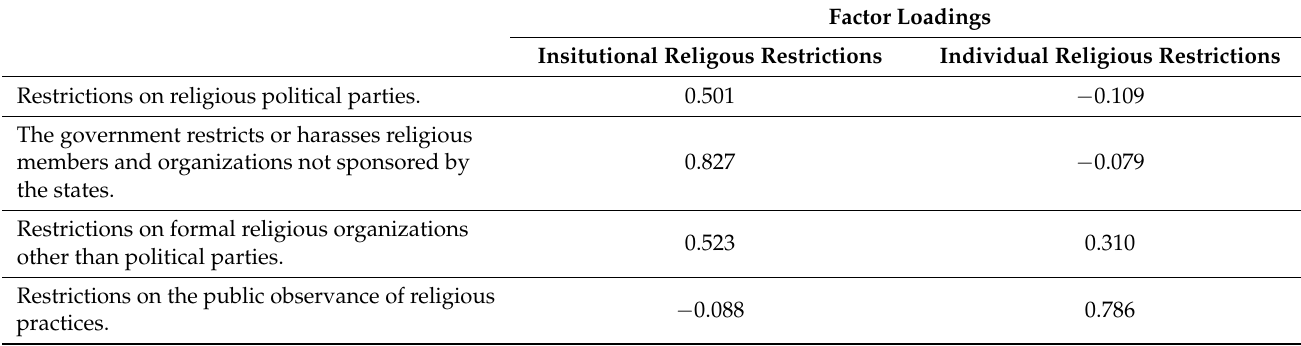
Table 2. The Factor Analysis Loadings for Government Religious Restrictions (NX)